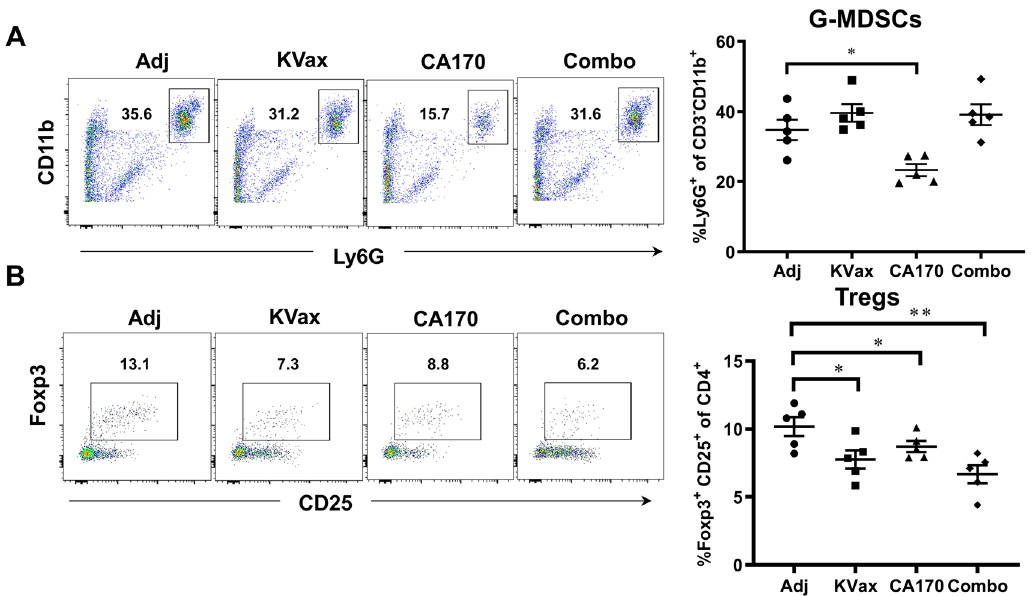
Fig. 3 CA170 decreases tumor-in fi ltrating Tregs and G-MDSCs. Lung tumors were processed into single cells, and the percent of G-MDSCs ( A ) and foxp3 + CD25 + Tregs ( B ) were determined by fl ow cytometry. Data are shown as the mean ± SE, n = 5, * P ≤ 0.05, ** P ≤ 0.01, *** P ≤ 0.001 vs